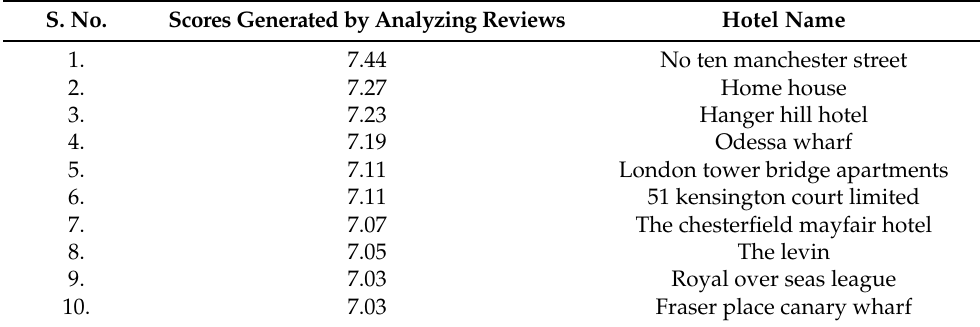
Table 12. Top-10 recommended hotels for the 875 Hotels of TripAdvisor by analyzing reviews. S. No.